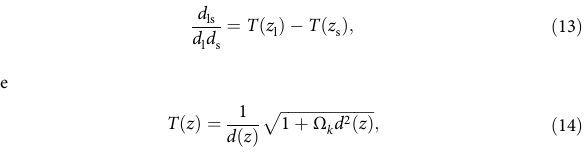
Fig. 6 The reduced χ 2 values by fi tting the mock data with true model (i.e., power-law) and the wrong model (i.e., Jaffe) when varying the exposure time from 1000